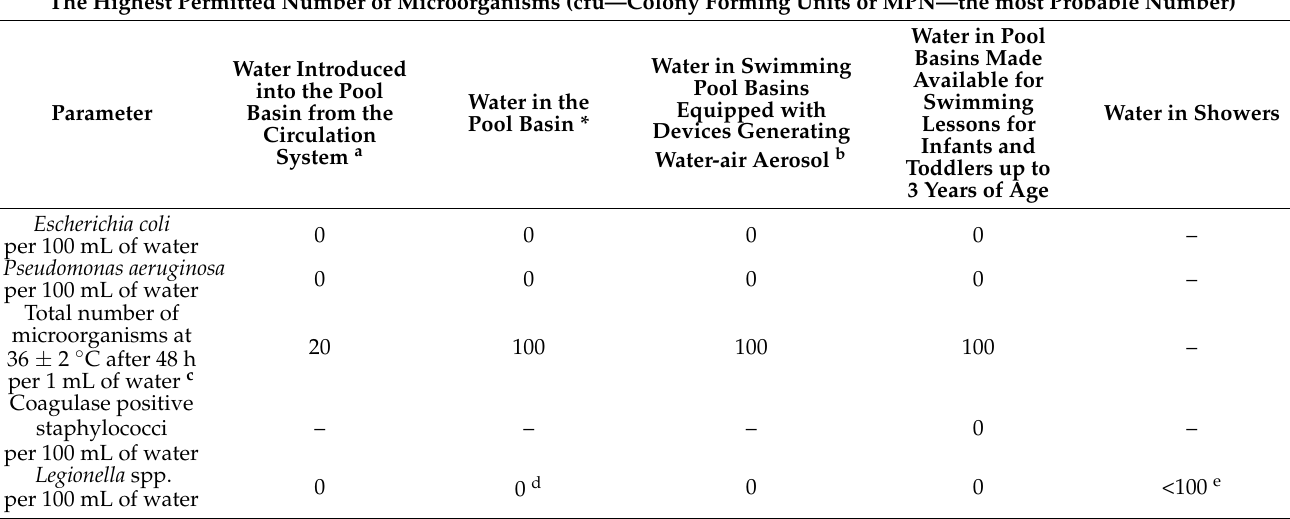
Table 6. The requirements for swimming pool waters